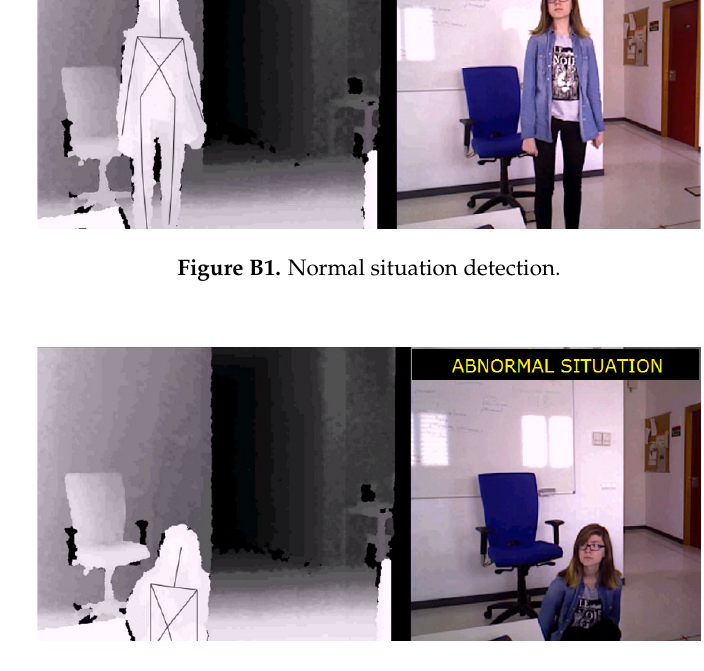
Figure B2. Abnormal situation detection.